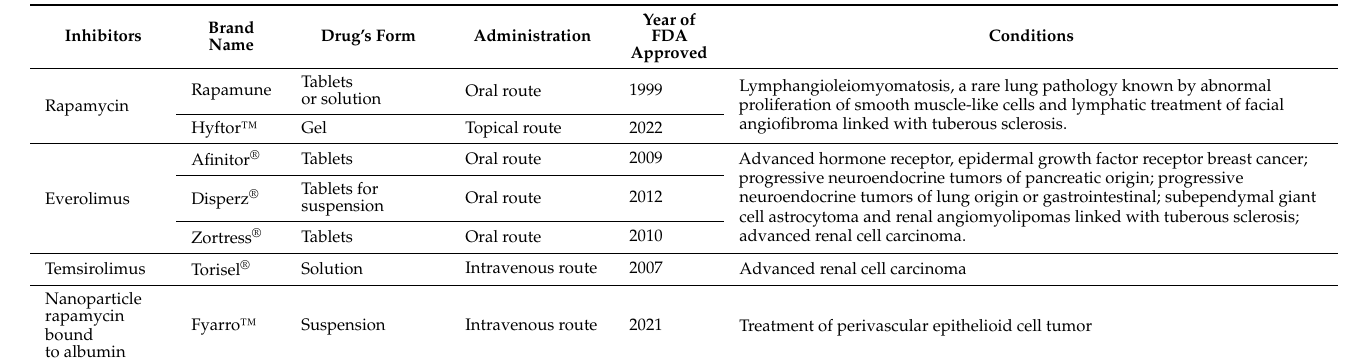
Table 2. List of synthetic compounds targeting mTOR signaling pathway which have been approved by the United States Food and Drug Administration (FDA)